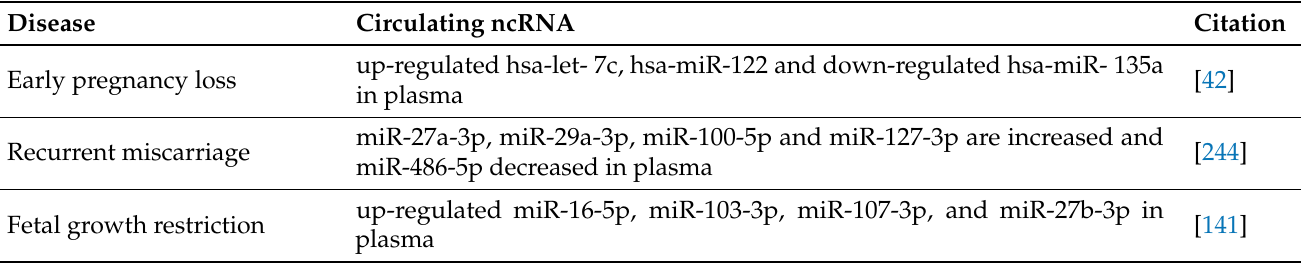
Table 4. Role of free circulating and exosomal ncRNAs in pregnancy-related diseases (selection).